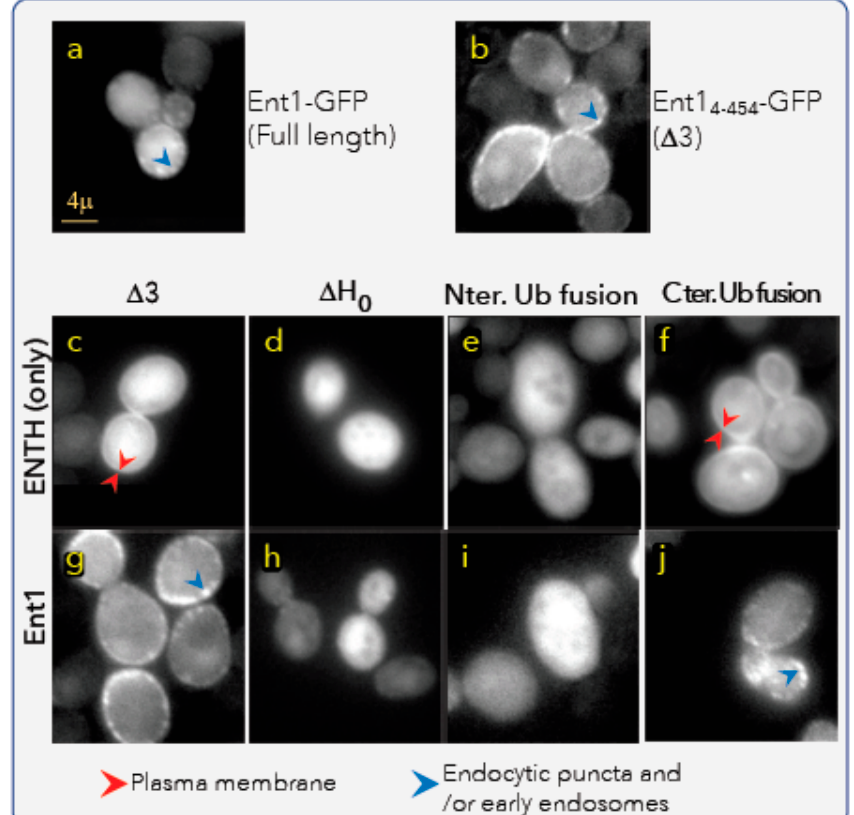
Figure 5. Ent1 and Ub–Ent1 membrane binding assays in vivo. Fluorescent microscopy imaging of living yeast cells expressing GFP fusion of the indicated Ent1 derivatives are shown. ( a ) A full-length Ent1 with C-terminus in-frame fusion GFP, expressed from the native genomic promoter. ( b ) An Ent1 4-454 ( ∆ 3) with C-terminus in-frame fusion GFP, expressed from a Gal promoter on a single copy plasmid. ( c – j ) The fluorescent readouts from indicated derivatives. ∆ H 0 is the construct that lacks the first 17 residues. In the Ub-fusion constructs, Ub was fused in-frame instead of K3 (i.e., to residue Q4). In the fusion-Ub constructs, Ub is fused in-frame at the C-terminus of the Ent1 derivative (between Ent1 and GFP). Red arrows mark probably endocytic or early endosome clusters of Ent1–GFP; yellow arrows mark the accumulation of Ent1-GFP fusions at the plasma membrane.